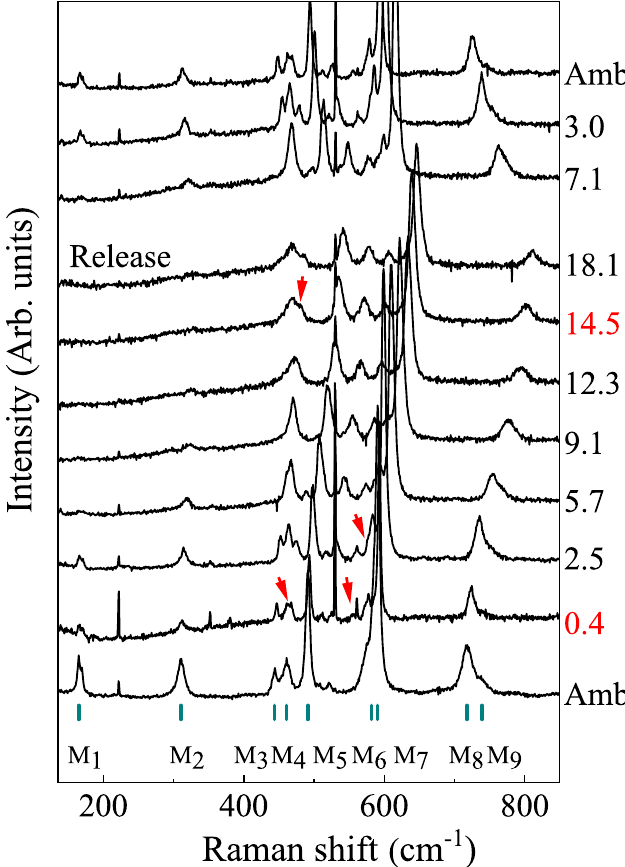
Figure 9. Raman spectra of LiInCr 4 O 8 at selected pressures. The numbers on the right are in GPa scale. Red arrows indicate the emergence of new Raman modes.